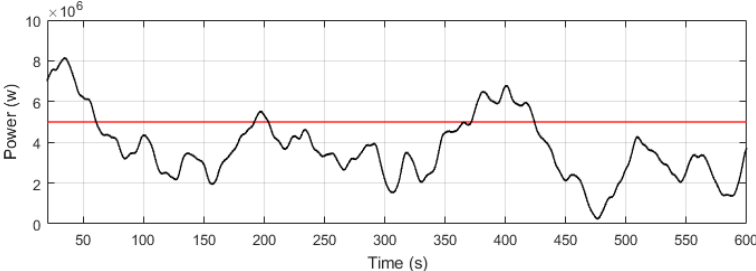
Energies 2016 , 9 , 535